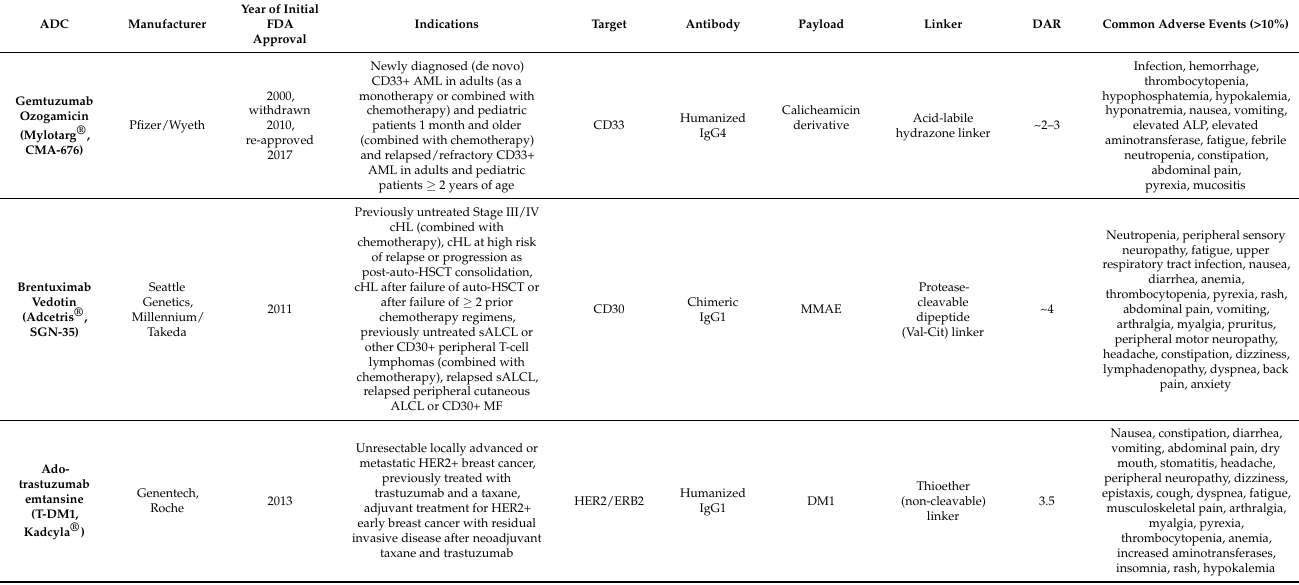
Table 1. Current indications and characteristics of FDA-approved